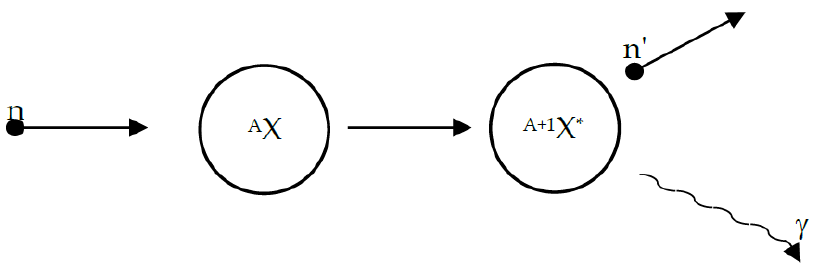
Figure 1. INS reaction illustration when a neutron is absorbed by a nucleus and a new neutron and gamma ray are emitted (* notes an excited nucleus).